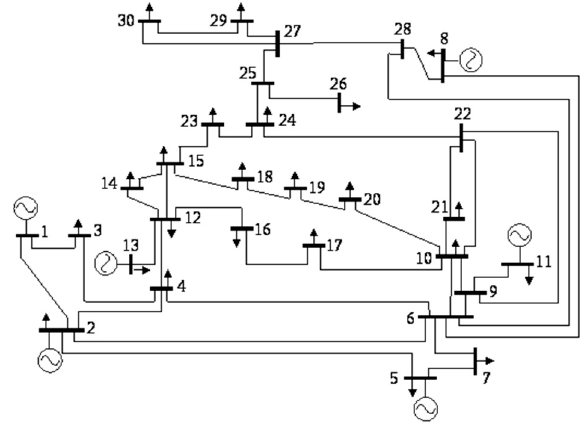
Figure 1. Single line diagram of 30-bus IEEE case test.